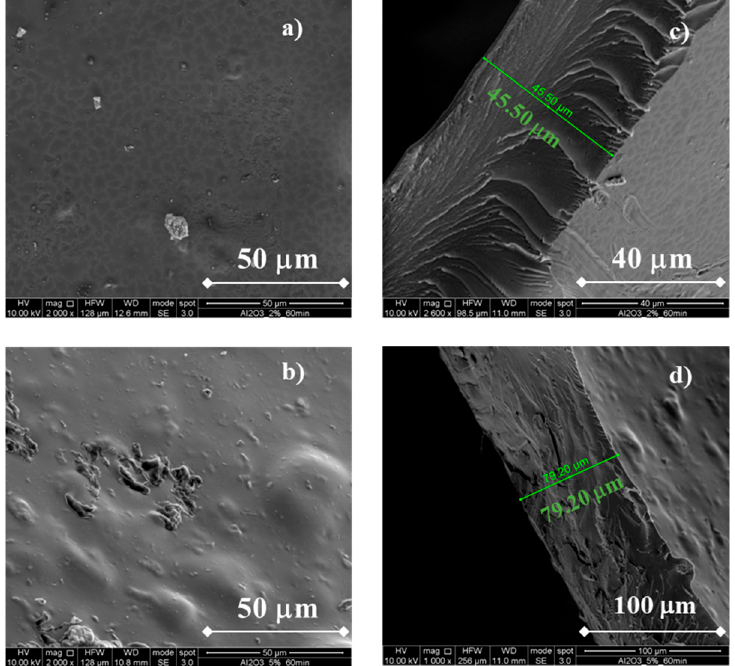
Figure 4. SEM cross-sectional micrograph of a CS/PTA membrane with Al 2 O 3 . Morphology of the ( a ) CS/PTA + Al 2 O 3 (2% wt) membrane, ( b ) CS/PTA + Al 2 O 3 (5% wt) membrane and cross section of the ( c ) CS/PTA + Al 2 O 3 (2% wt) membrane and ( d ) CS/PTA + Al 2 O 3 (5% wt) membrane.